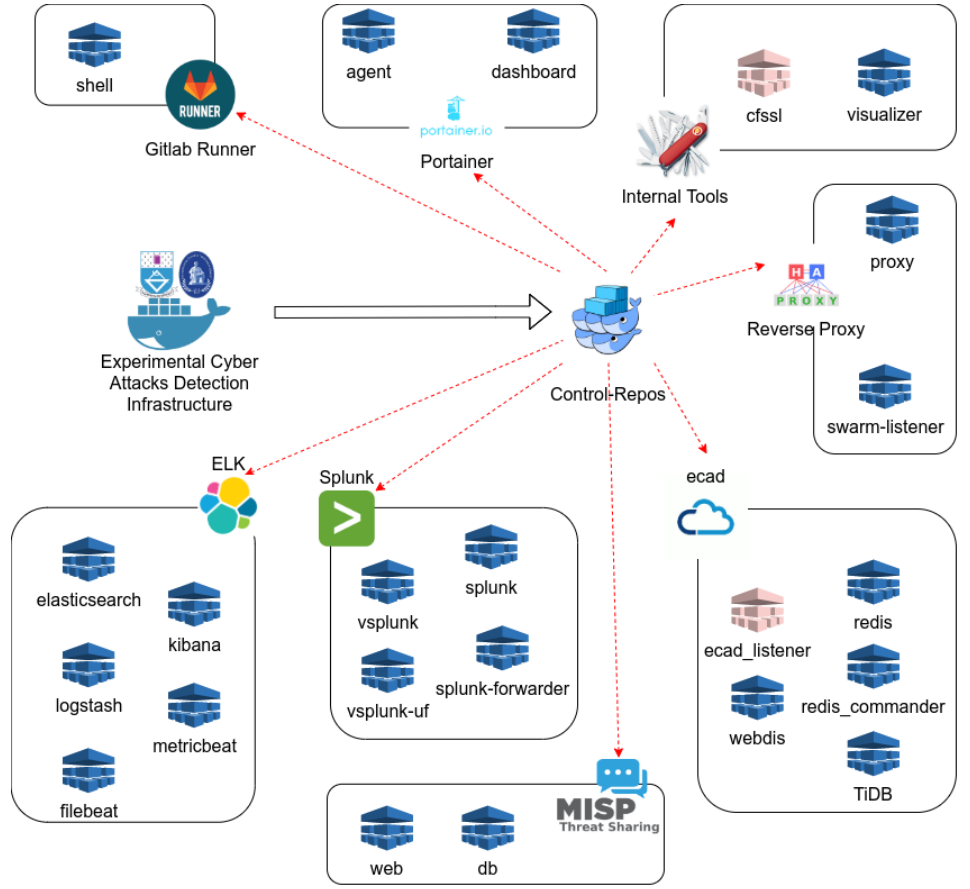
Figure 5. ECAD Stacks and